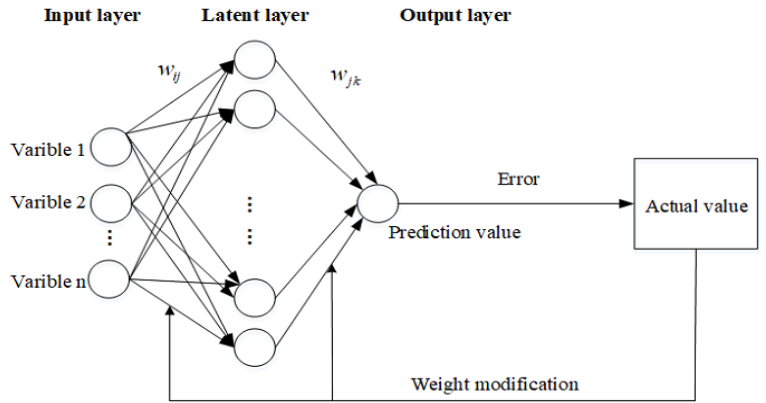
Figure 4. Three-layer BP neural network structure diagram [25].